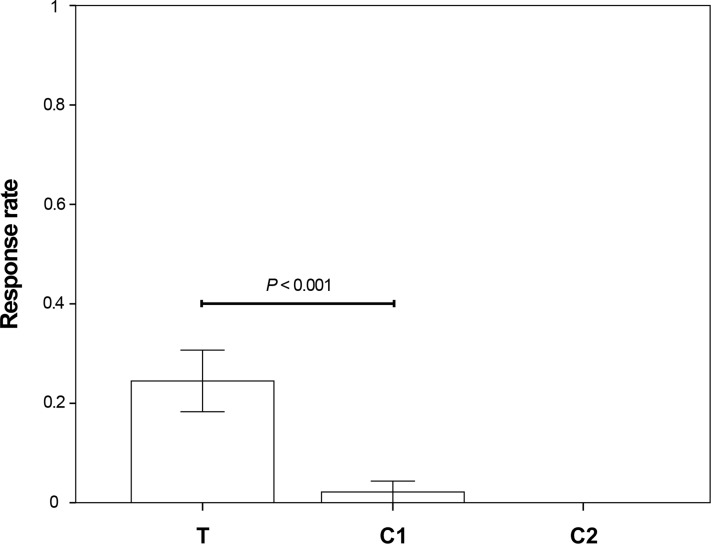
Relative response rate of test subjects for the three different test conditions (Tsubjects = 33, C1subjects = 29, C2subjects = 18; Ttrials = 49, C1trials = 46, C2trials = 33).Bars represent mean ± SE.